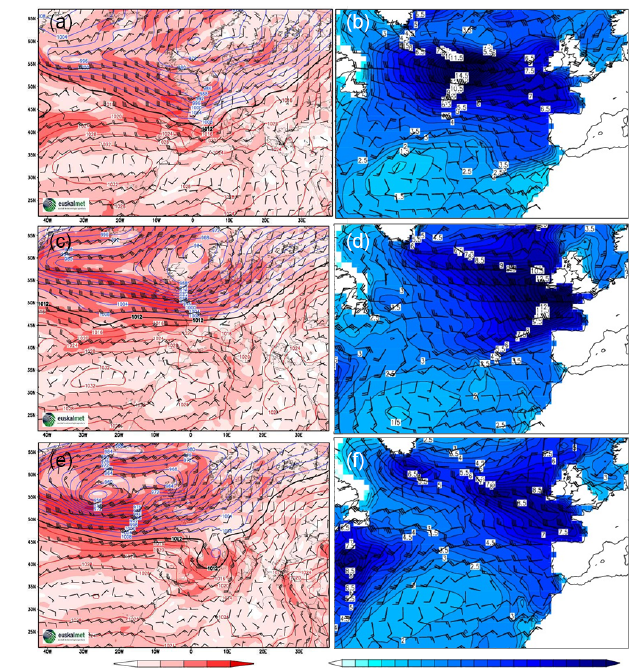
Figure 2. Sea-level pressure (SLP) and wind (a, c, e) and waves and wind at 12:00UTC (b, d, f) for 7, 8 and 9 February 2016 (top to